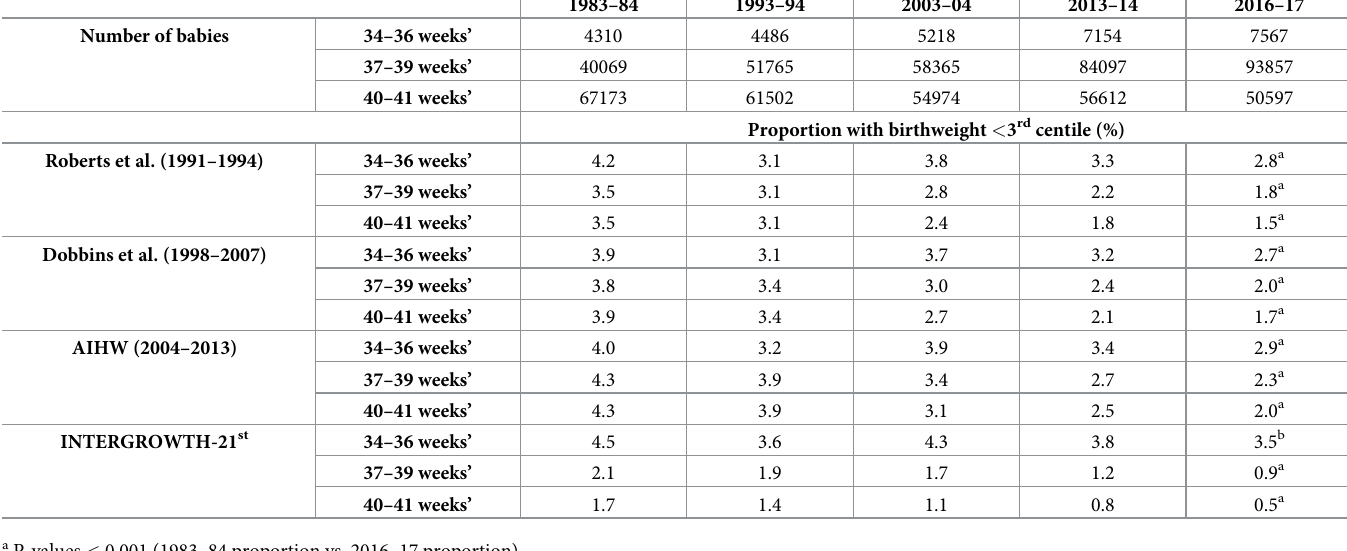
Table 4. Proportion (%) of babies born with birthweight < 3 rd centile at preterm, early term and late term gestations in each two-year epoch by birthweight centile chart.